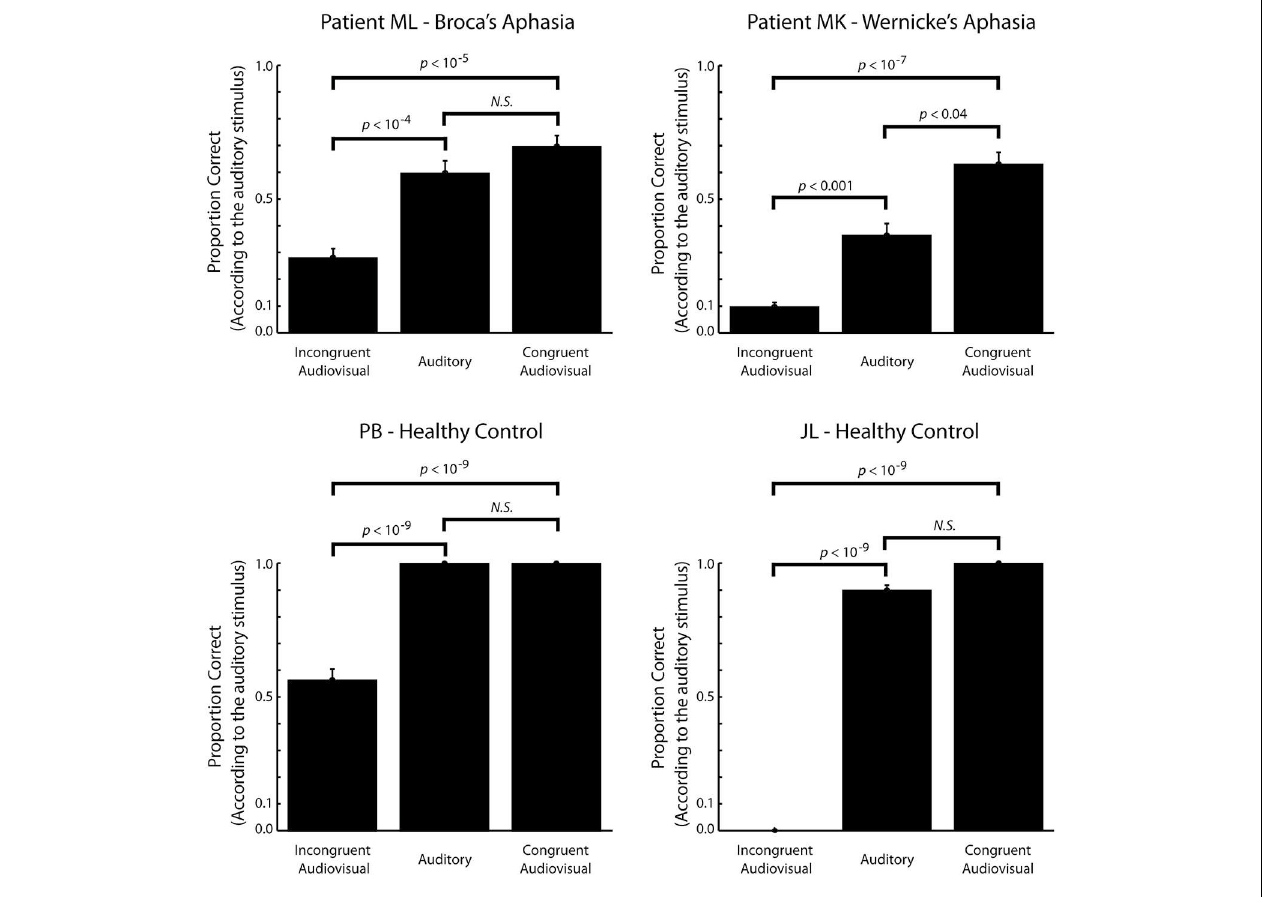
FIGURE 3 | The proportion correct (according to the auditory stimulus) as a function of stimulus type. For the incongruent audiovisual stimuli, a low proportion correct reflects a strong McGurk illusion. Only stimuli expected to elicit visual dominance, fusion or